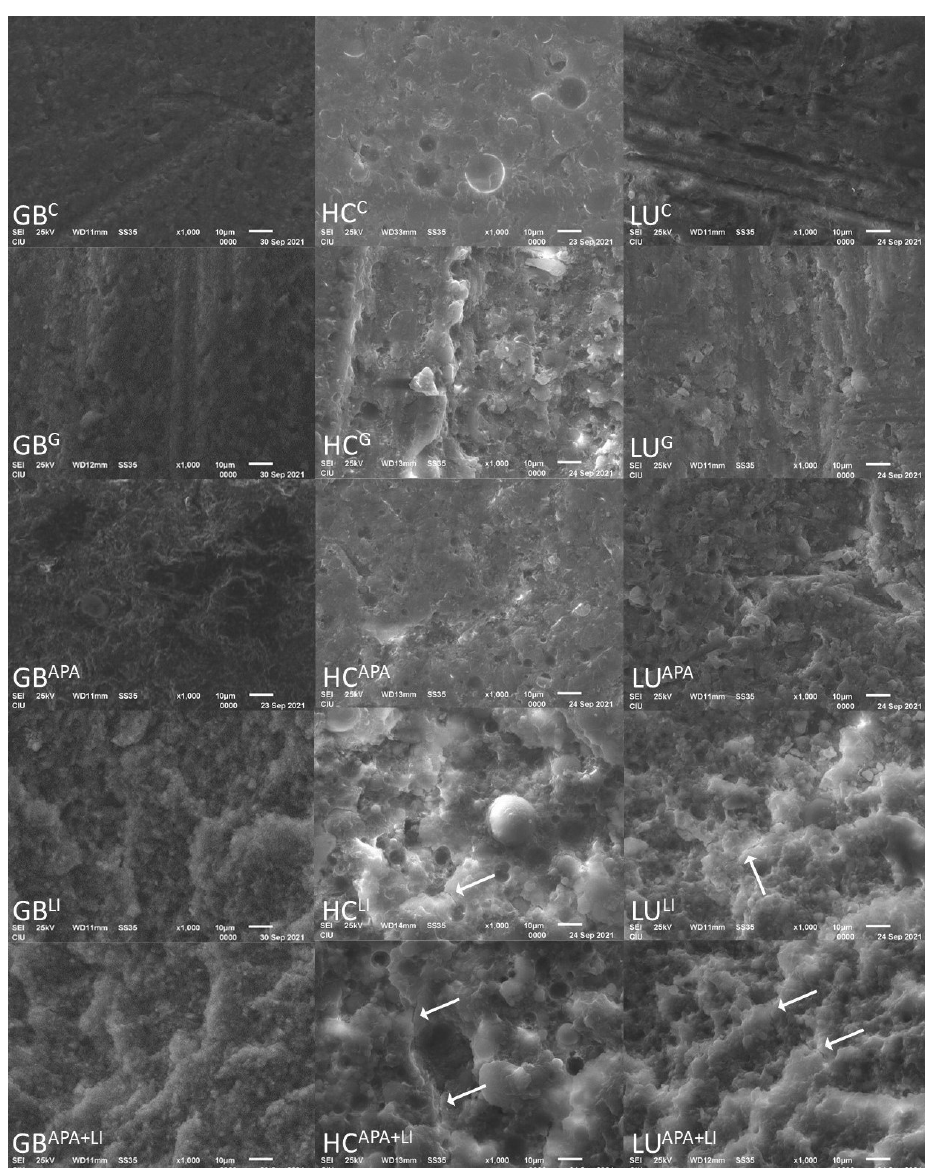
Figure 5. Scanning electron micrographs of specimens (×1000 magnification): GB, Grandio Blocs; HC, Shofu Block HC; LU, Lava Ultimate; C, Control; G, Bur grinding; APA, Airborne particle abrasion; LI, Er,Cr:YSGG laser irradiation; APA+LI, Airborne particle abrasion + Er,Cr:YSGG laser irradiation. White arrows indicate crack lines.